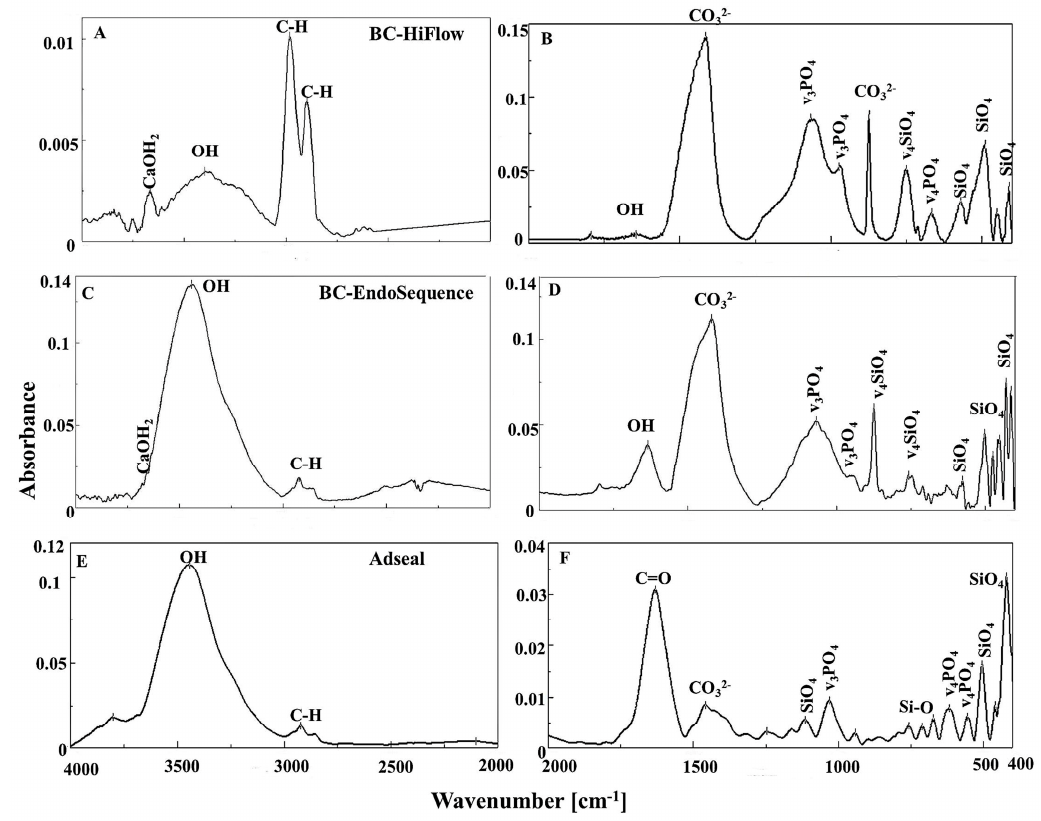
Figure 2. FTIR spectra at 4000–2000 and 2000–400 cm − 1 of BC-HiFlow ( A , B ), BC-EndoSequence ( C , D ) and Adseal ( E , F ) respectively showed their composition.